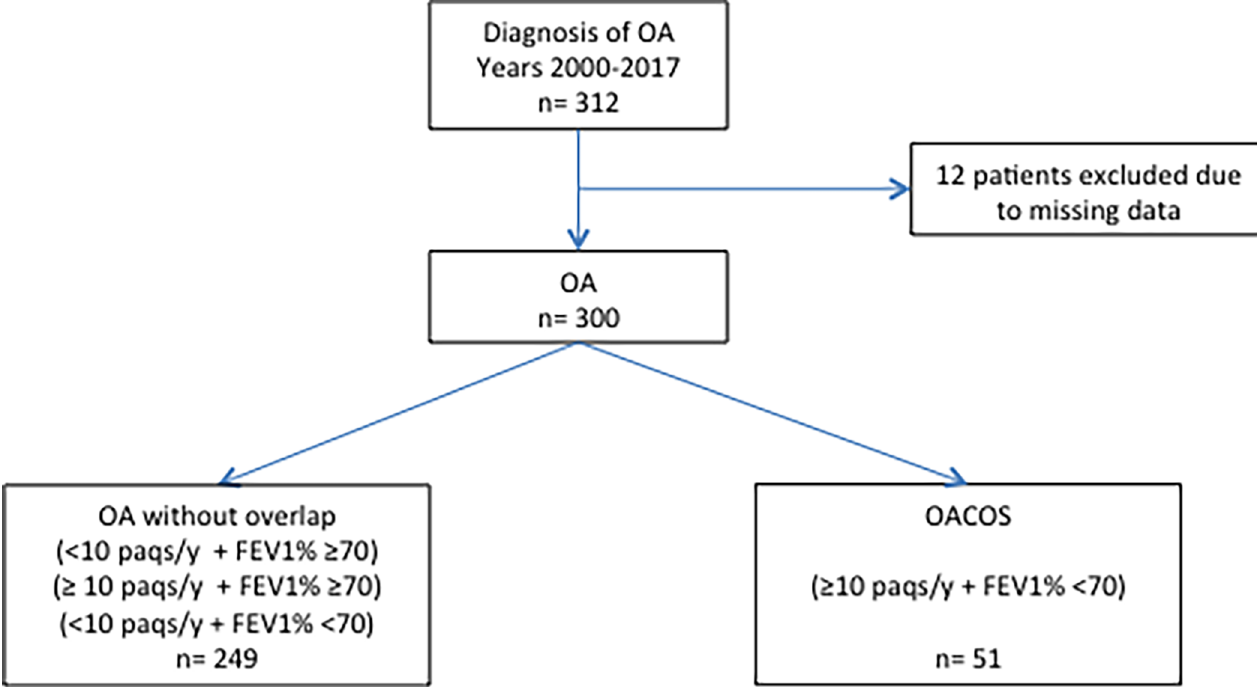
Fig 1. Study population. OA: occupational asthma; OACO: occupational asthma COPD overlap; FEV1: forced expiratory volume in the first second; FVC: forced vital capacity.